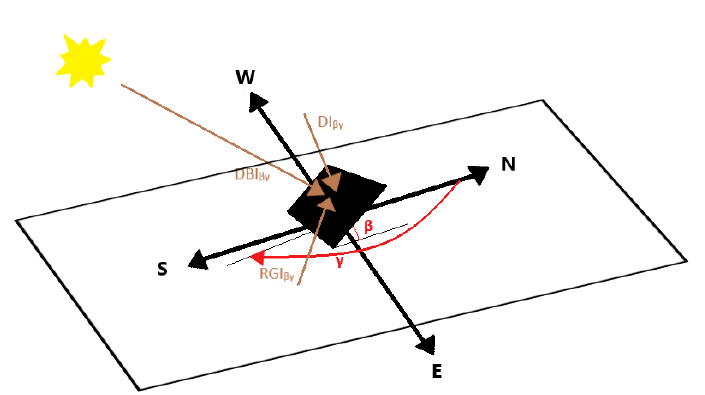
Figure 2. Graphical Presentation of the β tilt angle and γ azimuthal angle, alongside of Diffuse, Direct Beam and Reflective components of received solar irradiance.